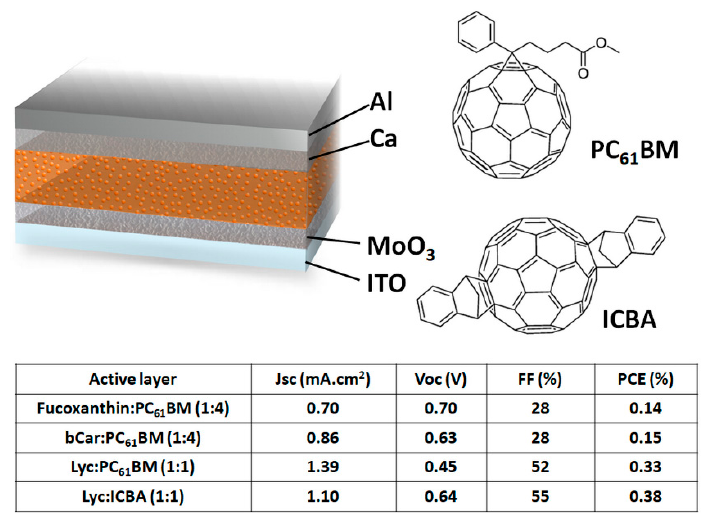
Figure 3. Schematic representation of the device architecture, molecular structures of electron acceptors and photovoltaic performances of the devices prepared in Reference [20].